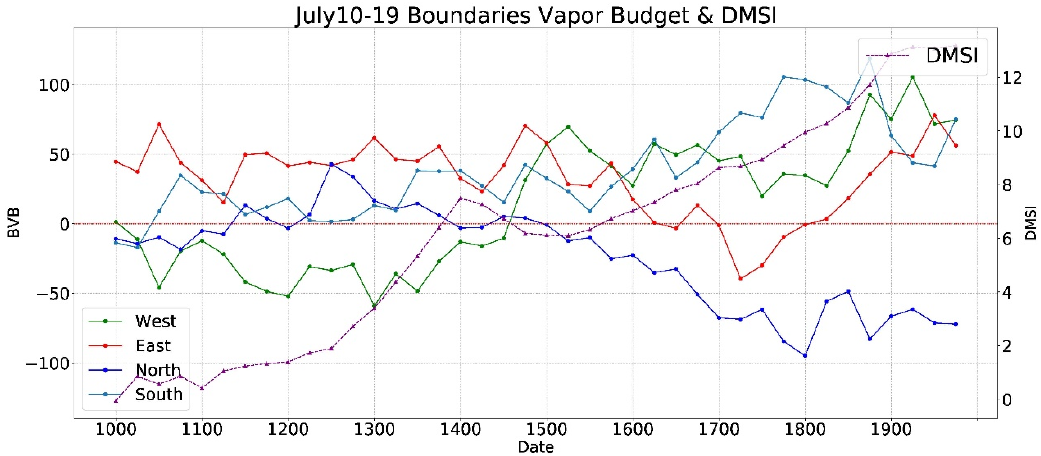
Figure 6. The BWVB (units: kg m − 1 s − 1 ) and DMSI during the lifetime of Rammasun.